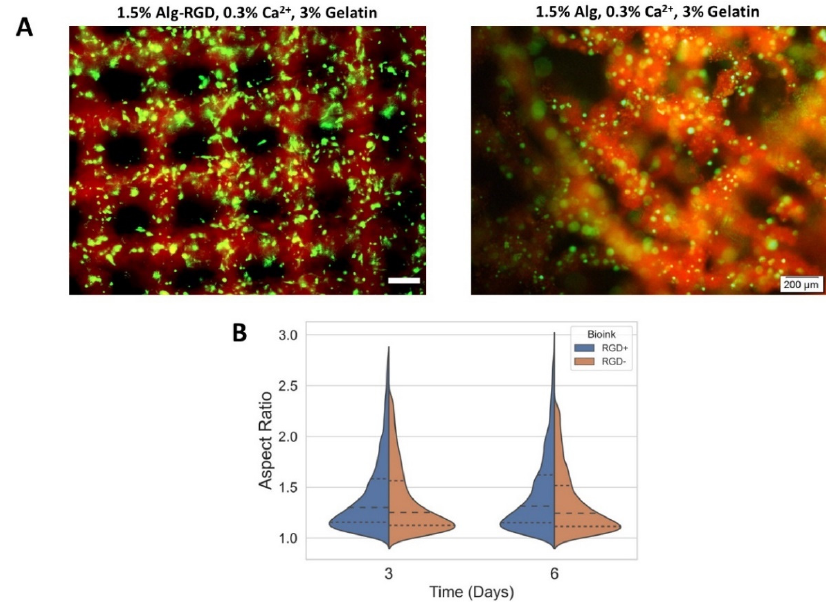
Figure A1. RGD-modified alginate improves 3D organization in 3D printed constructs. ( A ) Images of cell-laden constructs, 3D bio printed with 1.5% Alg-RGD, 0.3% Ca 2+ , 3% Gelatin (left) and 1.5% Alg, 0.3% Ca2+, 3% Gelatin (right), 6 days post printing. Scale bar: 200 µm. Green: F-Actin, red: Fluorescently labeled alginate. ( B ) Quantification of the cells aspect ratio measurements inside the 3D constructs over time. Data represented in quartiles.